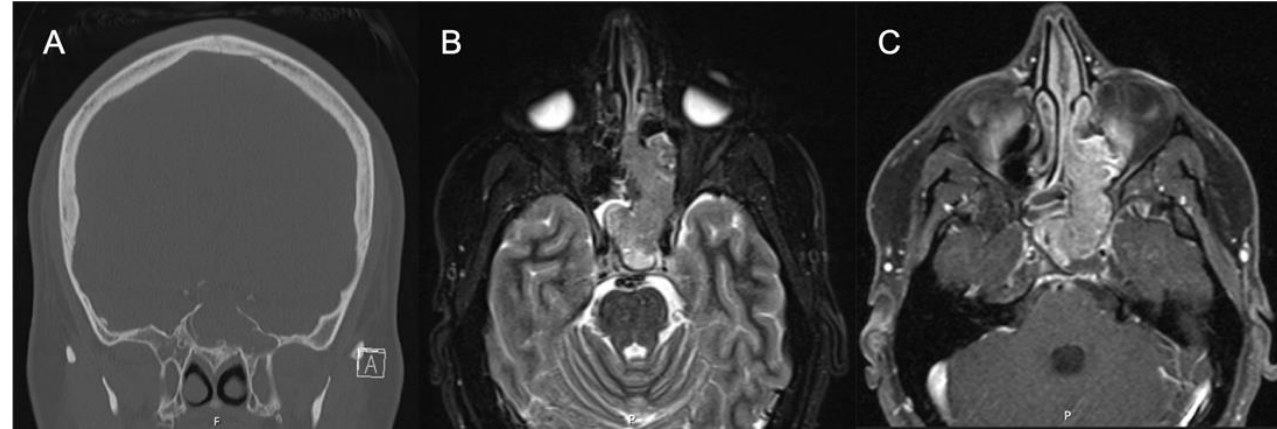
Figure 4. IP-degenerated squamous cell carcinoma. ( A ) Non-contrasted CT sinus demonstrating a mass of the left sphenoid with erosion of the skull base at the sella. ( B ) STIR sequence contrasted MRI demonstrating an expansile mass originating from the left sphenoid lateral wall. ( C ) T1 sequence contrasted MRI with fat suppression demonstrating a mass of the left sphenoid and ethmoid cavity.